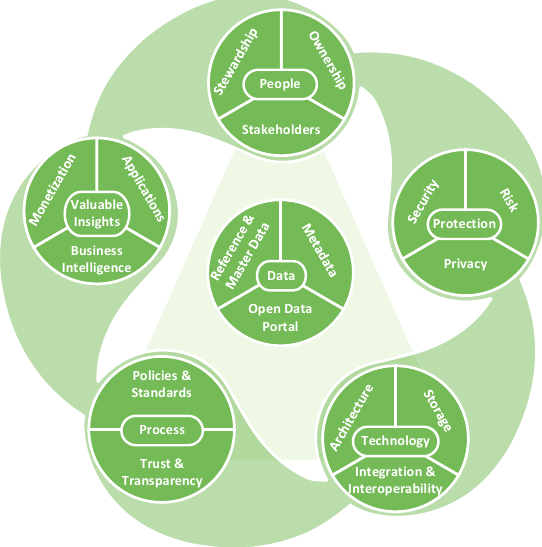
Figure 10 . Data Governance Framework for Smart